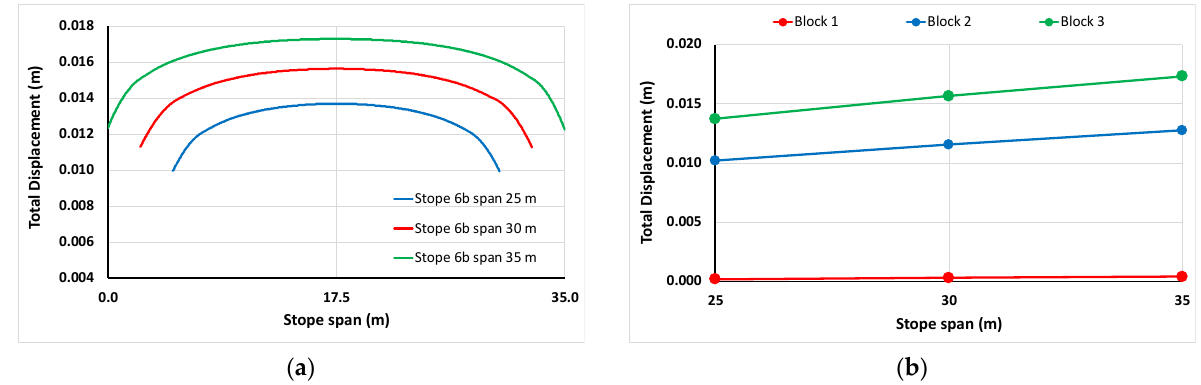
Figure 5. Variation of the total displacement ( a ) along the Stope 6b hanging wall line query in the Block 3 mining stage, for three different stope spans and ( b ) at the middle of the Stope 6b hanging wall for each mining stage vs. the stope span.